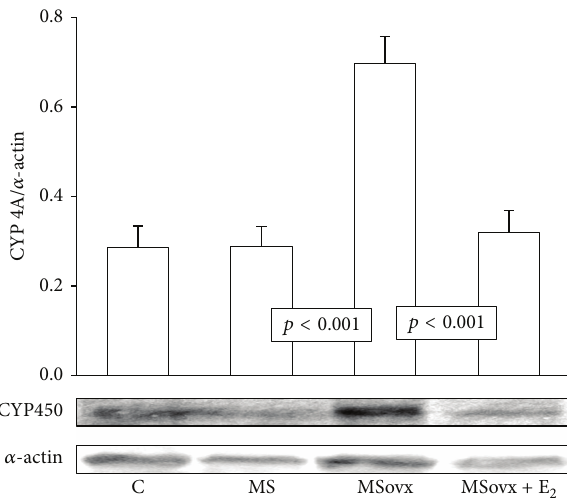
Figure 3: Representative densitometric analysis of Western blots for PLA 2 protein expression in kidney homogenate in experimental groups. Data are means ± SE; 𝑛 = 7 in each group.